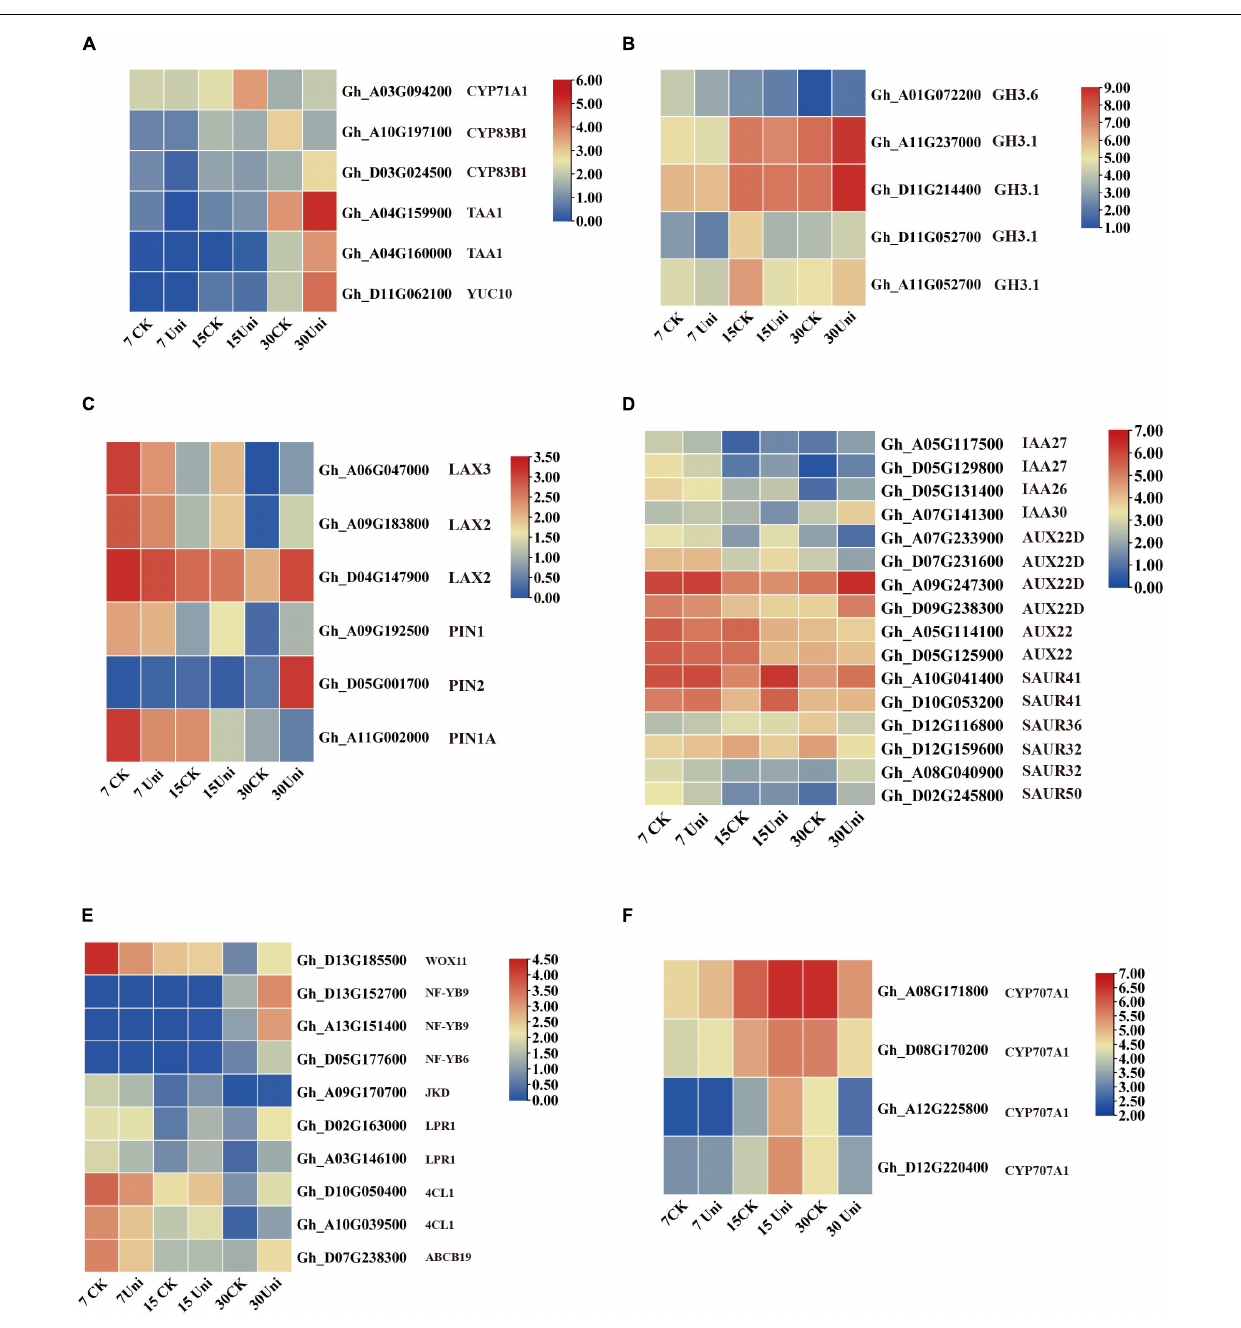
FIGURE 5 | Genes related to auxin, ABA, and somatic embryogenesis (SE) were differentially expressed in cultured callus with or without the supplementation of uniconazole. (A–D) Heat map of differentially expressed genes (DEGs) involved in auxin biosynthesis, metabolism, and signaling pathway, shown as Log2 values. (E) Heat map of DEGs involved in ABA metabolism pathway, shown as Log2 values. (F) Heat map of DEGs involved in transcription factors for SE, shown as Log2